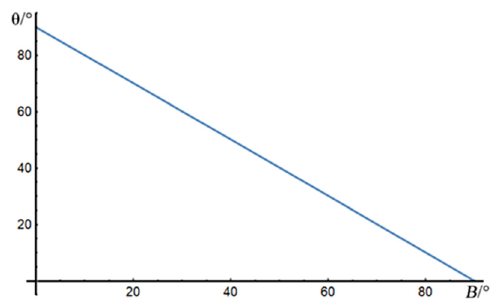
Figure 3. Sketch of conformal co-latitude 𝜃 with geodetic latitude B. According to Equation (3) and Figure 3, when 0° ≤ 𝐵 ≤ 90° , 𝜃 is always available. By substituting 𝜃 into Equation (2), the expression of the forward solution of the Gauss- Krüger projection complex function can be obtained: